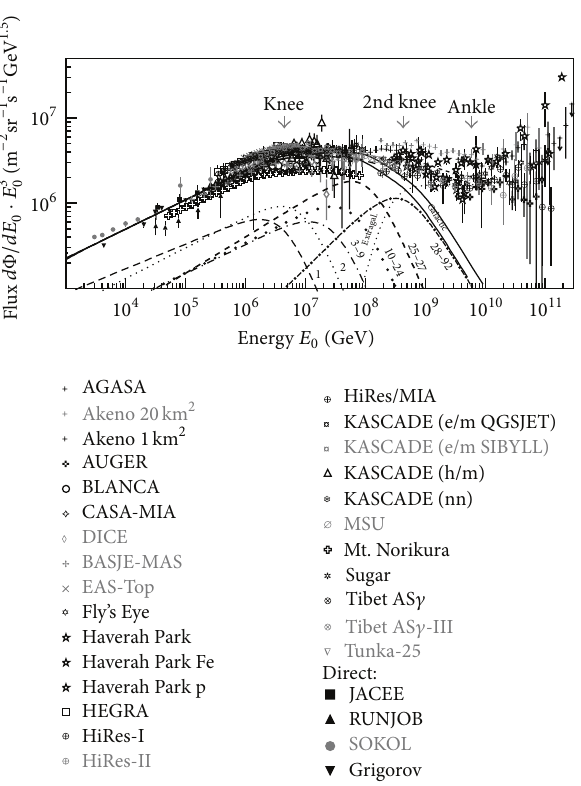
Figure 1: The all-particle cosmic ray energy spectrum multiplied by 𝐸 3 . The dots represent the results observed by all experiments. The curves show the results calculated following the polygonato model [15]. The contribution of each single element (marked with different number 𝑍 ) and the all-particle spectrum are shown separately.